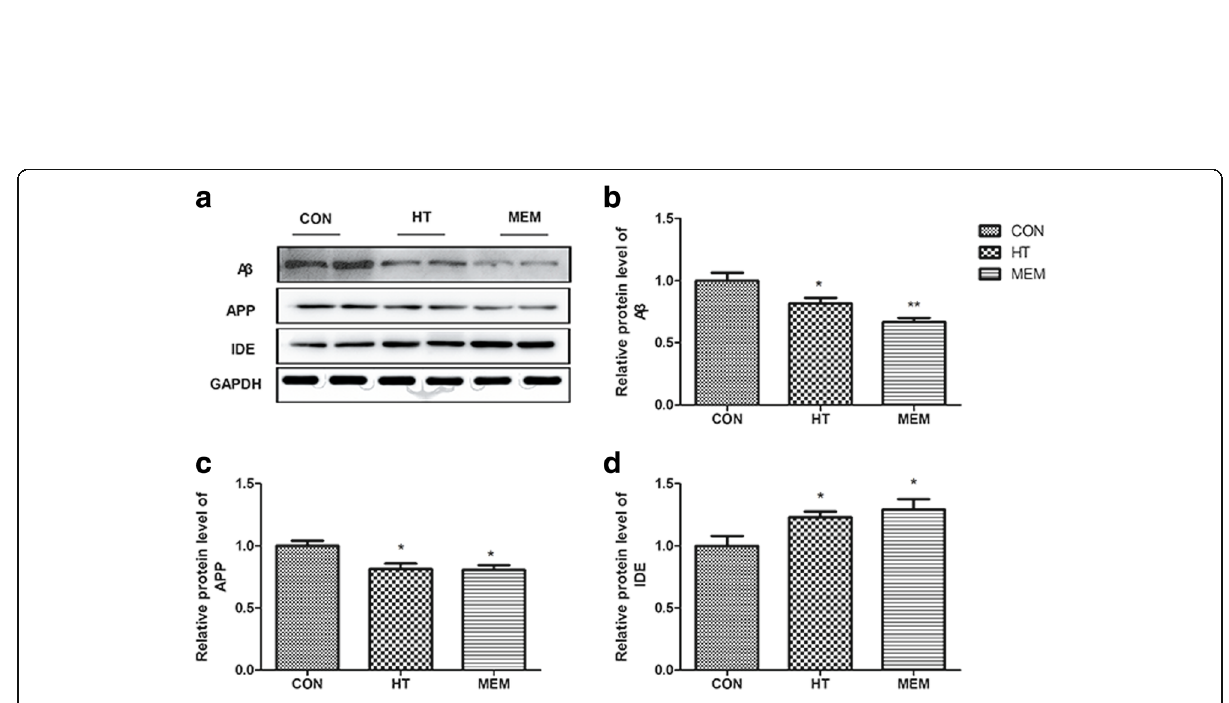
Fig. 7 HT reduced APP expression and upregulated IDE expression in the brains of APP/PS1 mice. a The protein levels of A β , APP and IDE were measured by Western blotting in the different groups. b Quantitative analysis of A β expression. * P <0.05 versus control group. c Quantitative analysis of APP expression. * P <0.05 versus control group. d Quantitative analysis of IDE expression. * P <0.05 versus control group, n =6 per